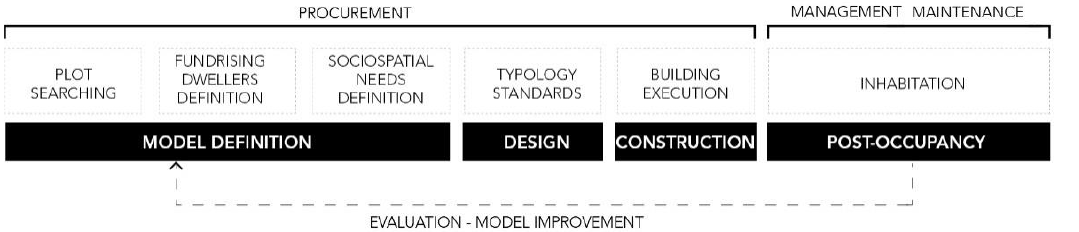
Figure 1. Dwellers are involved in all project phases from procurement to management and maintenance post completion. Source: authors.